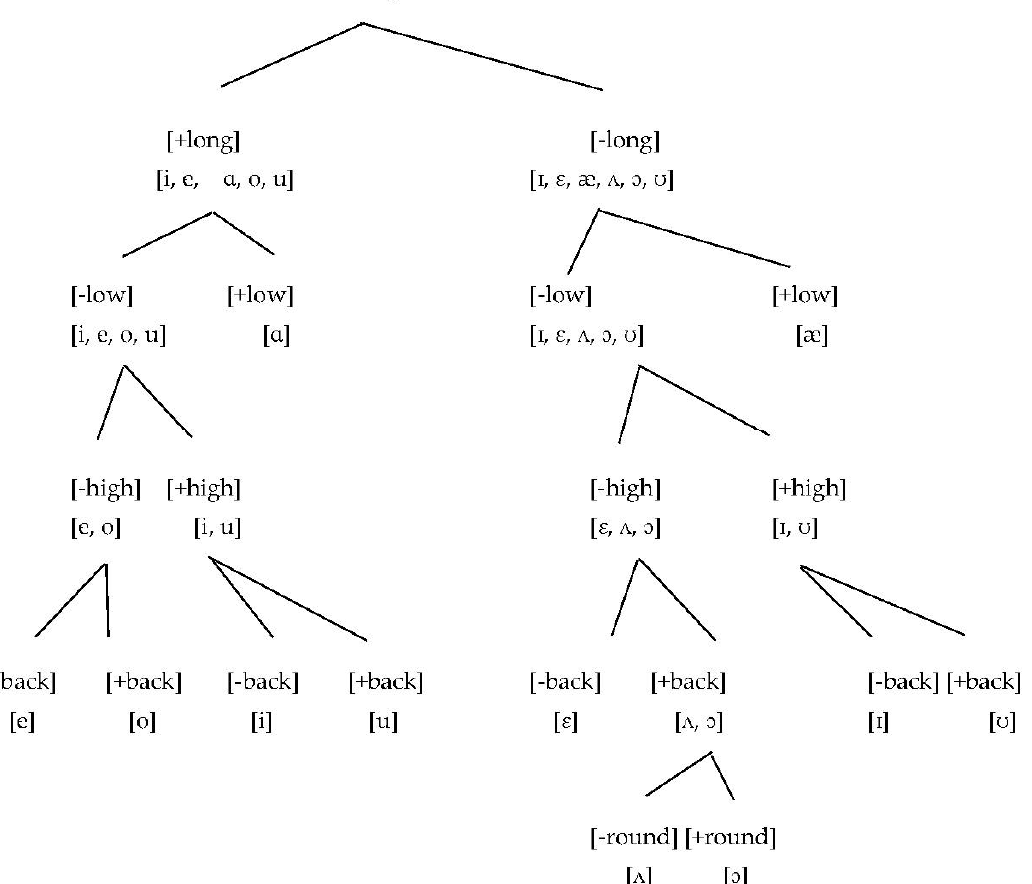
Figure 11. The French contrastive hierarchy applied to English vowels.